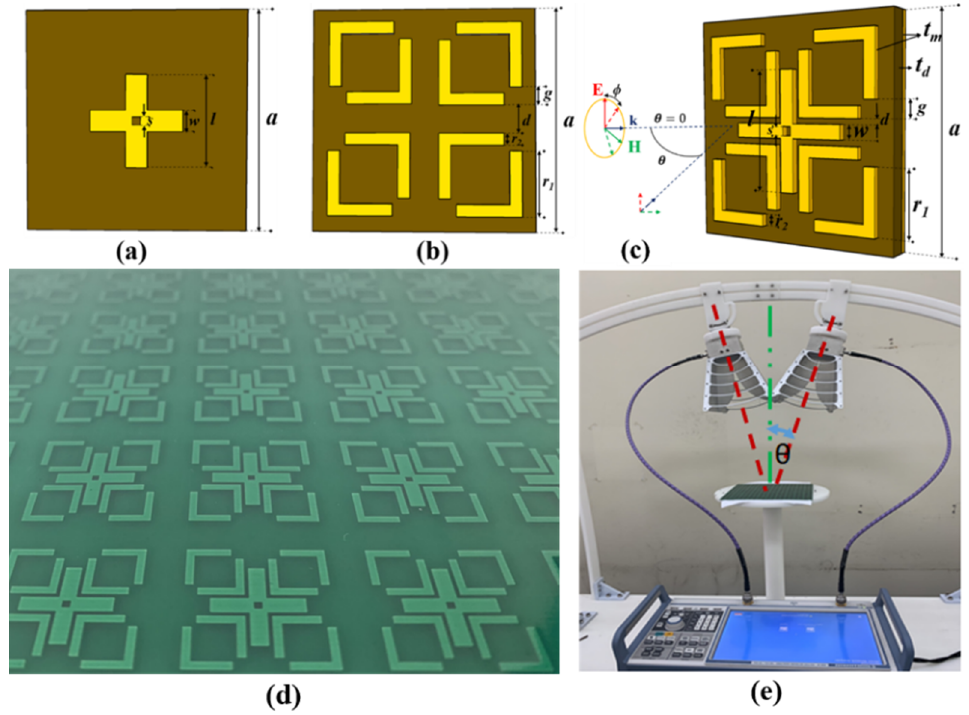
Figure 1. Unit-cell structure of the proposed MA: ( a ) CS structure, ( b ) SRR structure and ( c ) MA structure combined with two structures. ( d ) Fabricated MA sample and ( e ) measurement configu- ration. Table 1. Structural parameters of the MA.